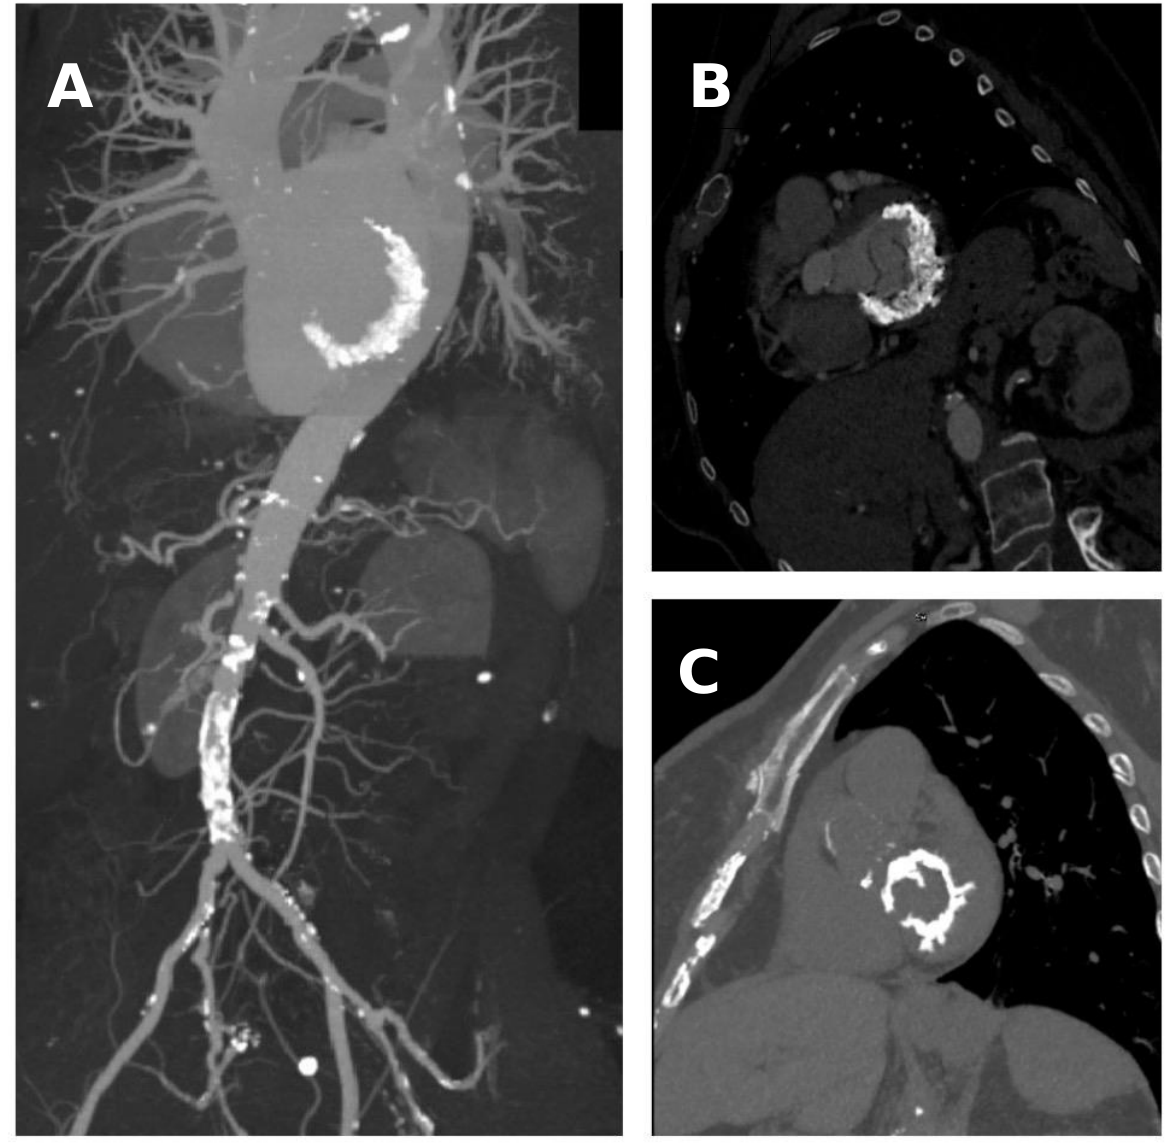
Figure 1. Severe MAC. ( A , B ): Heavily calcified annulus with a calcium thickness > 10 mm. ( C ): Cal- cium infiltration of the left ventricular free wall.